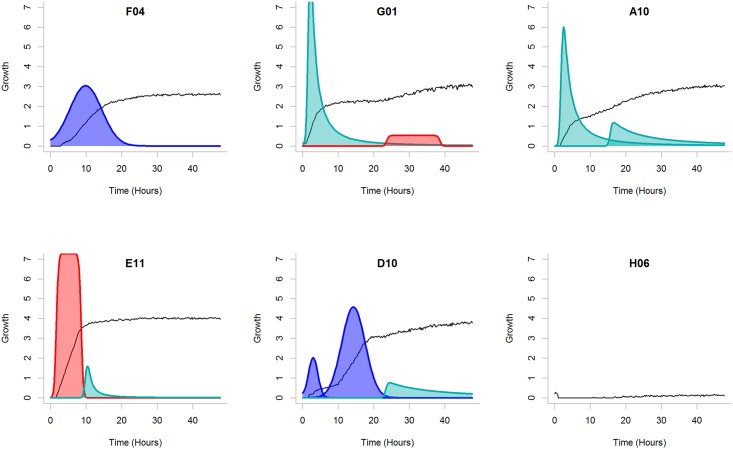
Example of the component decomposition.The signals generated by E. coli strain IMT17887 during growth on panel PM1. Substrates F04 (D-Threonine), G01 (Glycyl-L-Glutamic Acid), A10 (D-Trehalose), E11 (2-Deoxy Adenosine), D10 (Lactulose) and H06 (L-Lyxose) were analysed. The black lines show the analysed raw signal (not to scale). The different colour corresponds to the type of the components (turquoise for slope, red for brick and blue for Gaussian). One component was identified in F04, three in D10 and two in G01, A10 and E11. In H06 no growth is visible. The algorithm parameters were set as follows: blur strength b = 0.5, threshold δ = 20, correlation weight γ = 2.